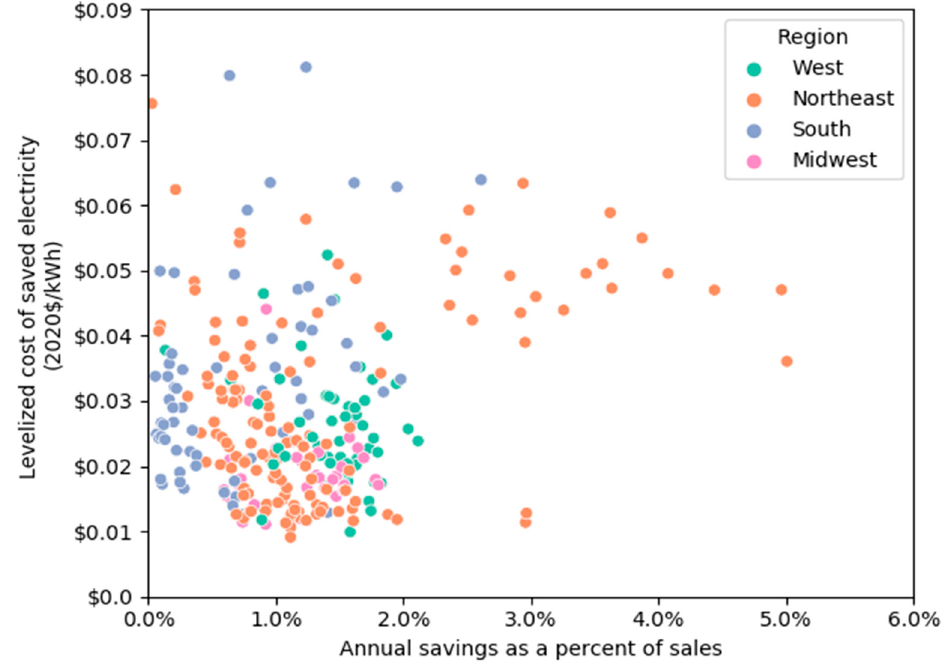
Figure 2. Levelized cost of saved electricity by annual savings as a percent of sales 2010–2018.